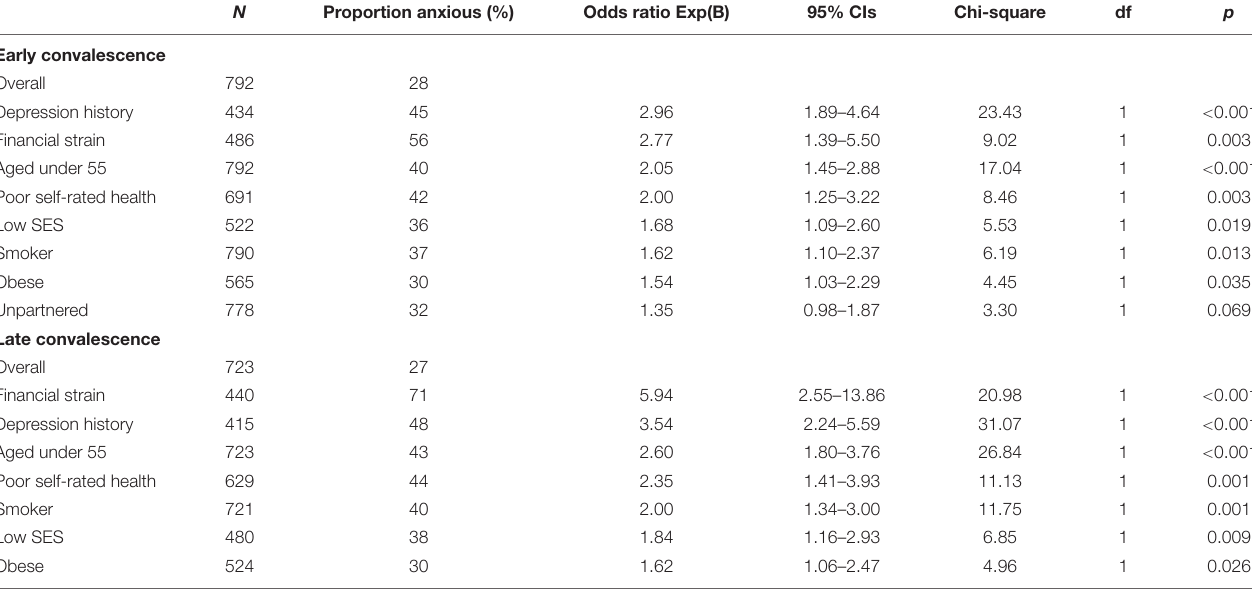
TABLE 2 | Factors associated with anxiety in early and late convalescence.